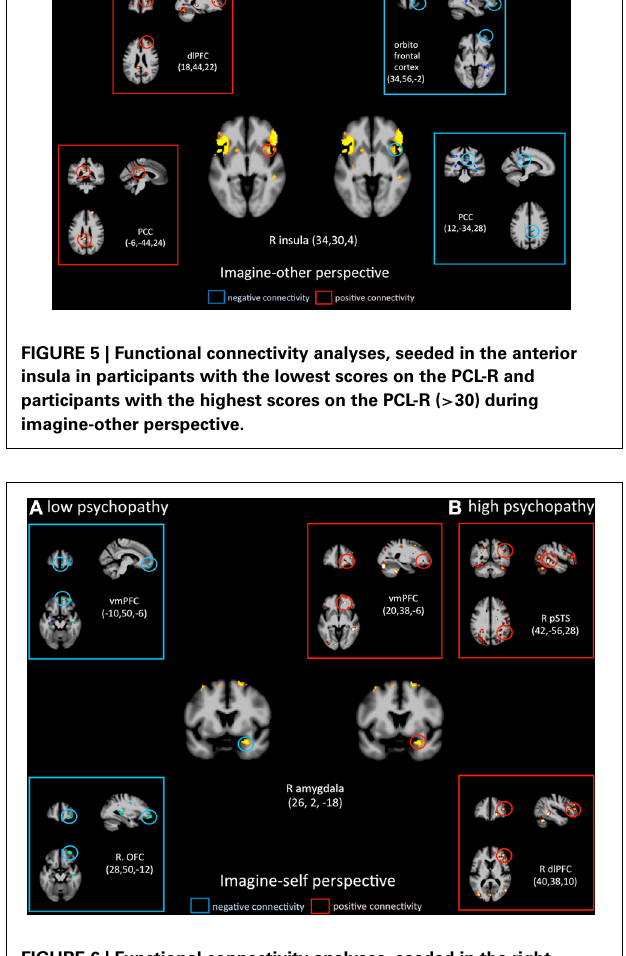
FIGURE 6 | Functional connectivity analyses, seeded in the right amygdala in participants with the lowest scores on the PCL-R ( ≤ 20) and participants with the highest scores on the PCL-R ( ≥ 30) during imagine-self perspective.